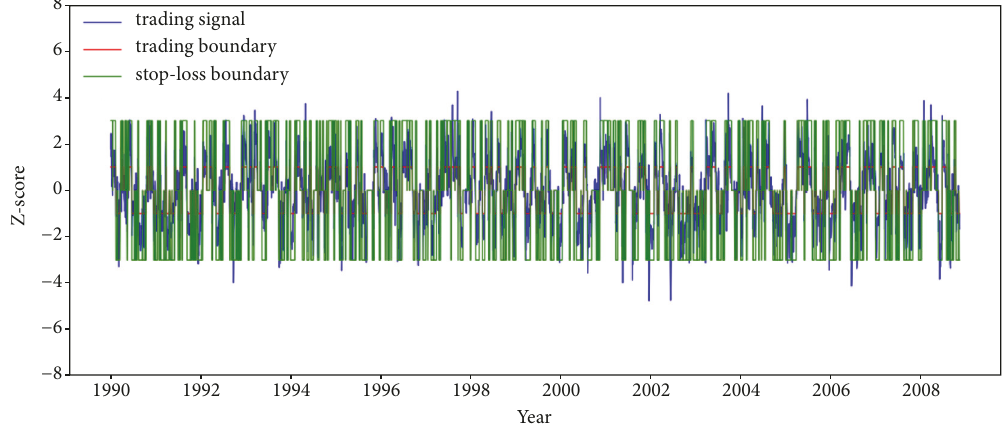
Figure 6: An example of PTA1 based on a training scheme using